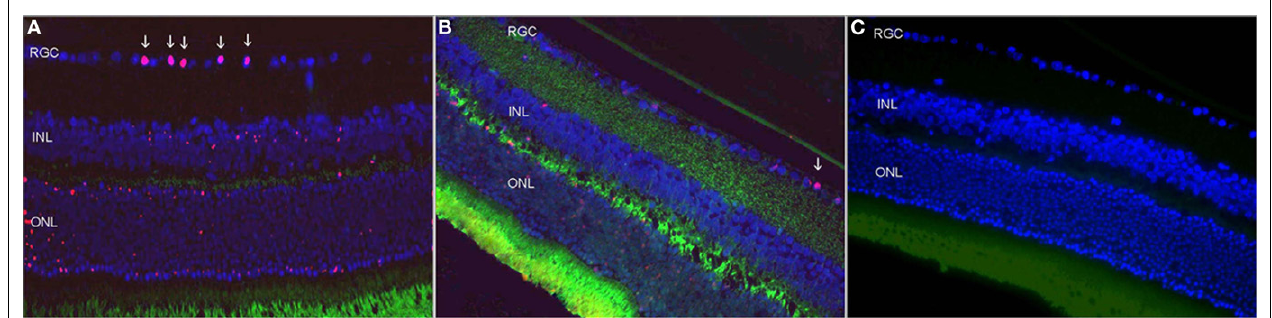
FIGURE 2 | Retinal ganglion cells apoptosis 3days after rAION induction. (A) Untreated eye after rAION induction. Note theTUNEL-positive cells (red)